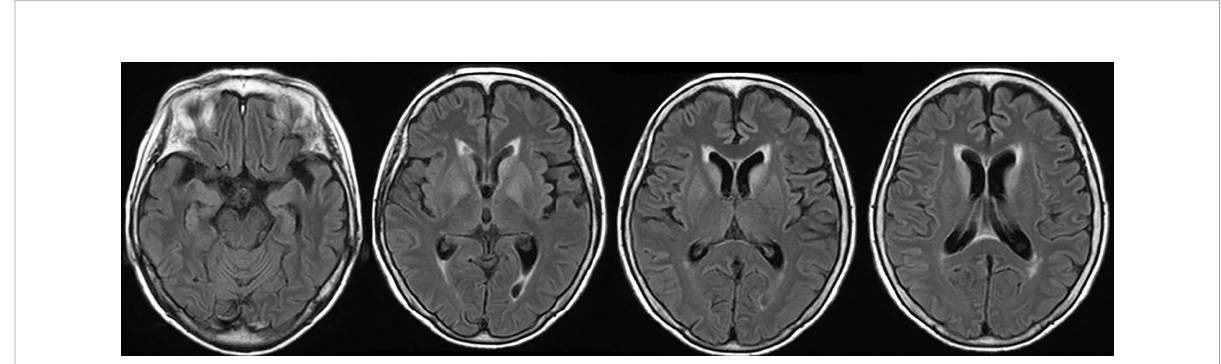
FIGURE 1 Brain MRI showed symmetric increased fl uid-attenuated inversion recovery signals in the basal ganglia and medial temporal